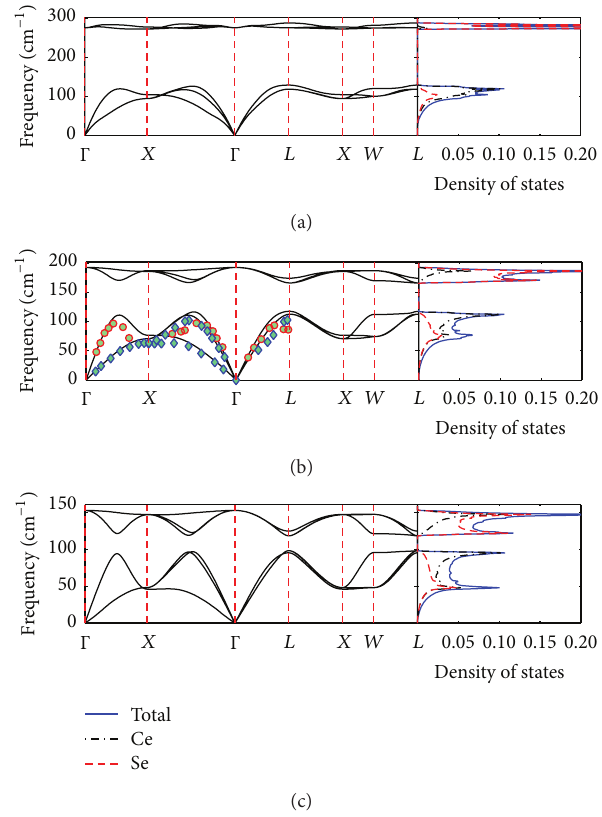
Figure 8: Phonon dispersions and the total and projected density of phonon states for (a) CeS, (b) CeSe, and (c) CeTe. The experimental acoustic mode frequencies of CeSe are shown with circle and diamonds and are from